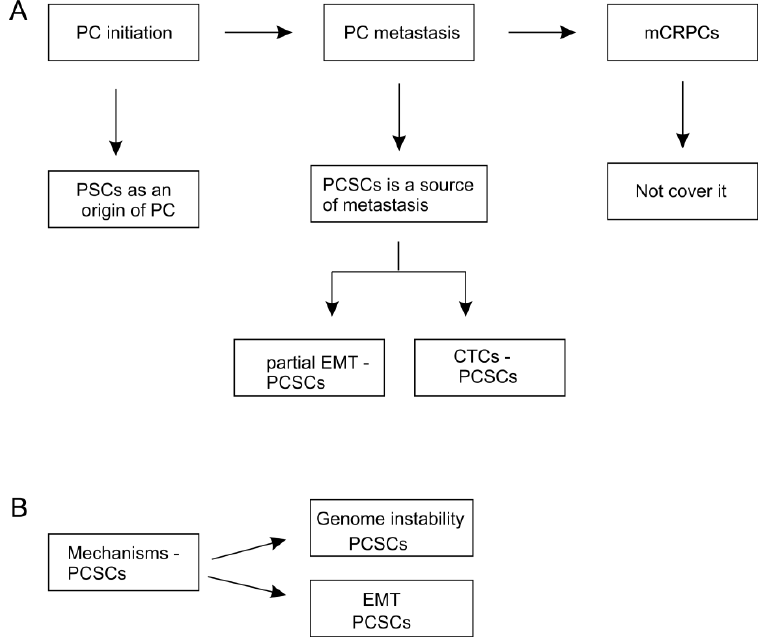
Figure 1. Review manuscript organization. ( A ) The typical prostate cancer (PC) pathogenesis involves tumor initiation, progression to metastatic diseases, and metastatic castration-resistant prostate cancers (mCRPCs) following androgen deprivation therapy (ADT) treatment. Prostate cancer stem cells (PCSCs) contribute to all these processes; this review will not cover the contributions of PCSCs to CRPC, but rather focus on the other two processes. PSC: prostate stem cells; CTCs: circulating tumor cells. ( B ) The mechanisms that regulate PCSC stemness will be